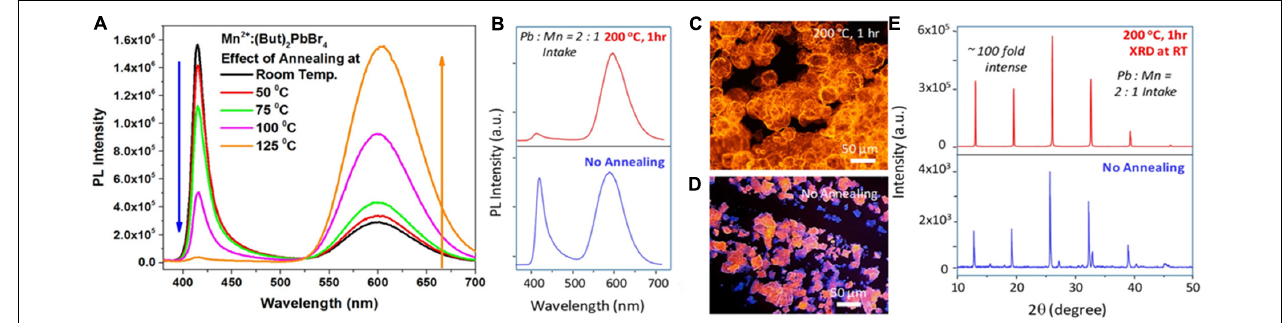
FIGURE 3 | (A) PL spectra of Mn 2 + -doped (butylammonium) 2 PbBr 4 annealed at different temperature. (B) PL spectra of Mn-doped (butylammonium) 2 PbBr 4 microcrystals after (top, red) and before (bottom, blue) annealing at 200 ◦ C for 1 h, (C,D) optical microscopic images under UV irradiation ( λ = 340-380 nm), and (E) corresponding powder XRD patterns. (A,B–E) are adapted from Biswas et al. (2017) and Dutta S. K. et al. (2019), respectively, with permission from the American Chemical Society.